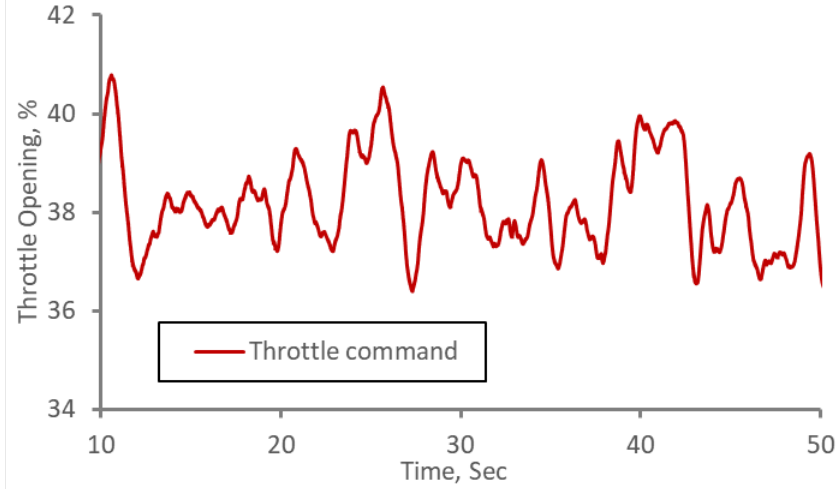
Figure 13. Throttle command of plowing operation simulation.